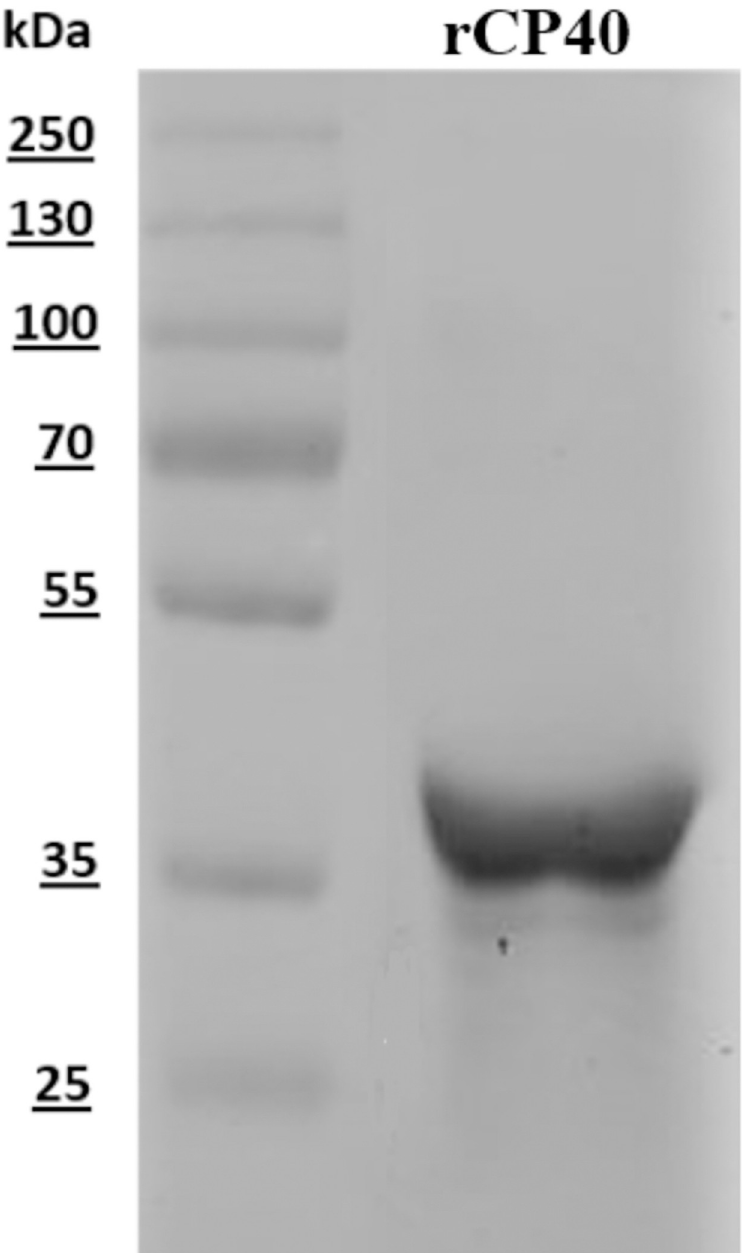
Fig 3. SDS-Page for purification evaluation. Purification of rCP40, literature compatible molecular weight, 40kDa. challenge assay (60 days), animals were evaluated every day for the sites of challenge inocula- tion, the internal organ, lymph nodes were examined for internal abscesses and samples were collected from abscesses for, reisolation of C . pseudotubercuosis or any other clinical sign of the disease (CLA). Looking for the survival curve (Fig 6). The G5, G6, G7 and G8 groups did not present protection, despite showing 10% survival of animals, when compared with the control group G1 and G2 both were not able to provide protection. The controls G1 and G2 survival